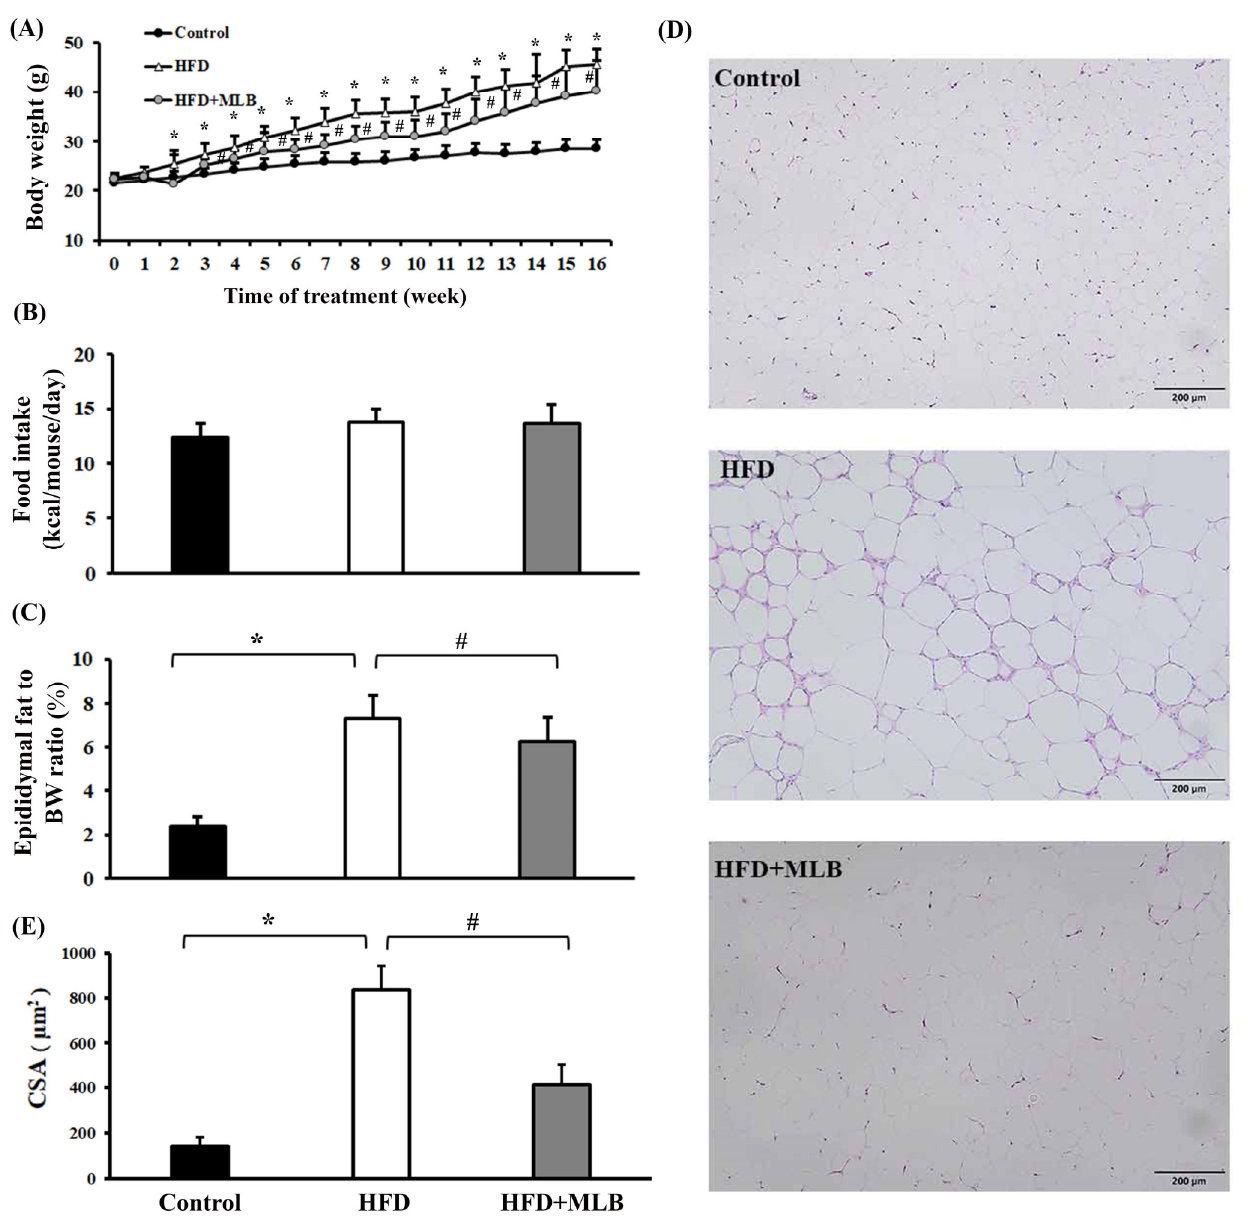
Figure 1. MLB supplementation attenuated HFD-induced adiposity. Over the course of 16 weeks, the mice’s body weight and food intake were recorded. Weekly changes in body weight ( A ) and food intake ( B ) are depicted and summarized. At the end of the experiment, the excised epididymal adipose tissues were weighed ( C ) and subjected to histological examination. Representative photomicrographs of H&E stain are displayed ( D ) and the relative epididymal adipose cross-sectional area (CSA) data are illustrated ( E ). * p < 0.05 vs. control group. # p < 0.05 vs. HFD group. n = 8. Scale bar: 200 μm.